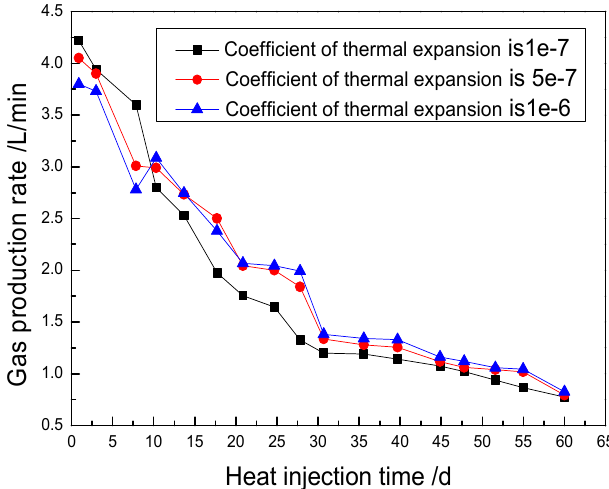
Figure 11. E ff ect of di ff erent thermal expansion coe ffi cient on gas production Figure 11. Effect of different thermal expansion coefficient on gas production rate.